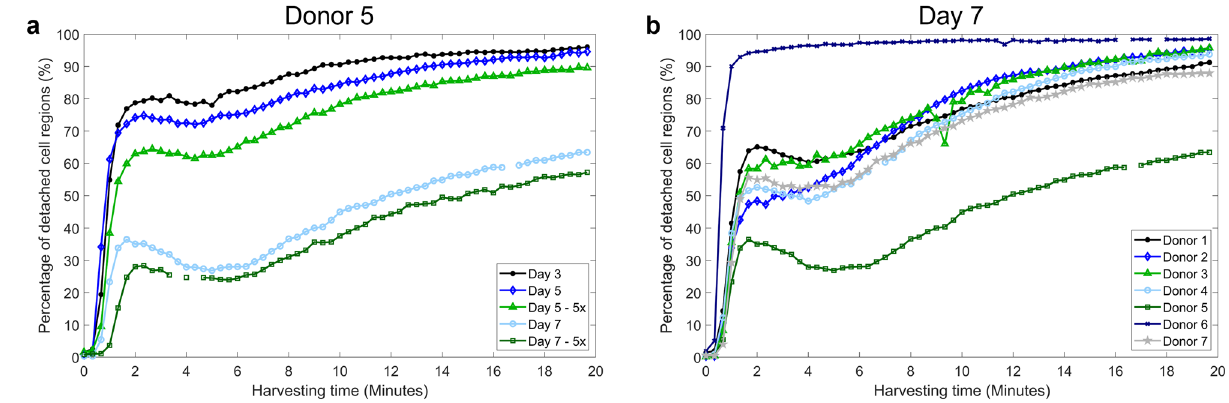
Figure 7. Cell detachment over time. ( a ) Detachment response of donor HP297 for the different conditions. ( b ) Detachment response of the different donors after 7 days in culture (enzymatic solution not